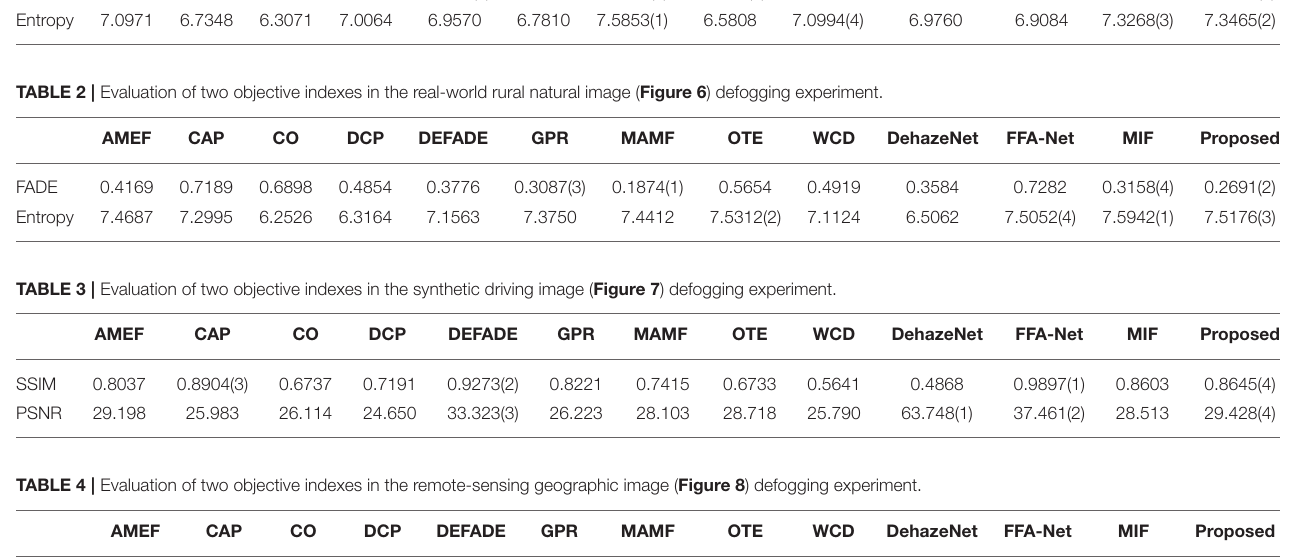
AMEF Proposed FADE